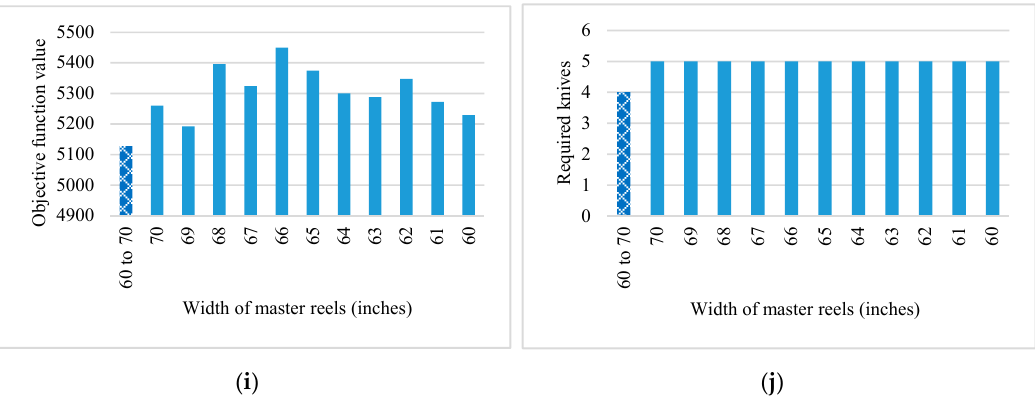
Figure 3. Comparison of the outcomes of adjustable and fixed widths of master reels.